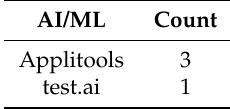
Table A14. 5.e. Do you use some Artificial Intelligence (AI) and/or Machine Learning (ML) approach in your Selenium